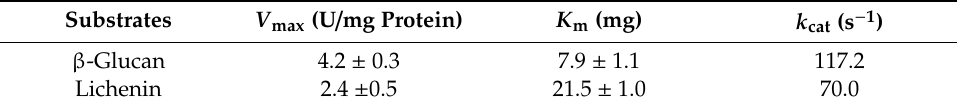
Table 2. The kinetic parameters of the stable monomeric oligomer of the Exg-D enzyme.